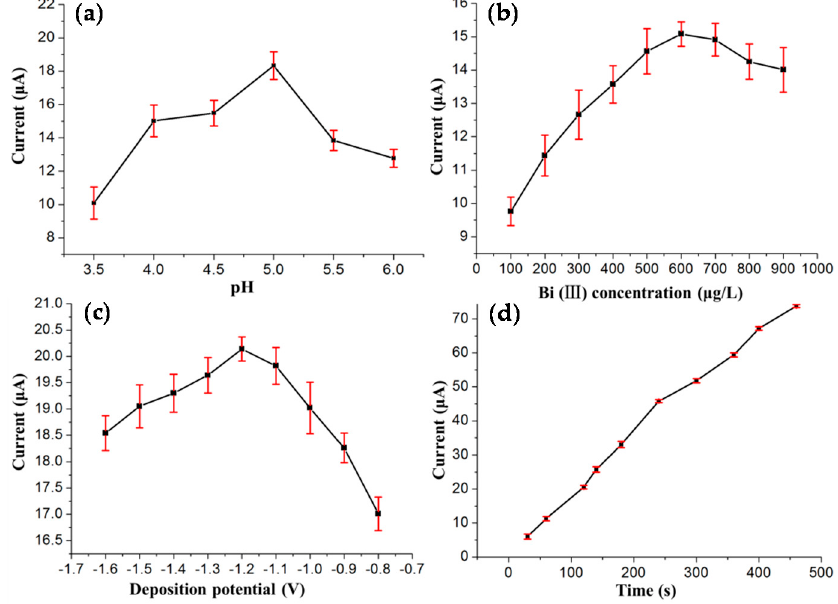
Figure 2. Effects of ( a ) pH value; ( b ) Bi(III) concentration ( c ) deposition potential; and ( d ) deposition time on the stripping peak currents of 50 µ g/L Pb(II) in the presence of 20 µ g/L Cd(II).